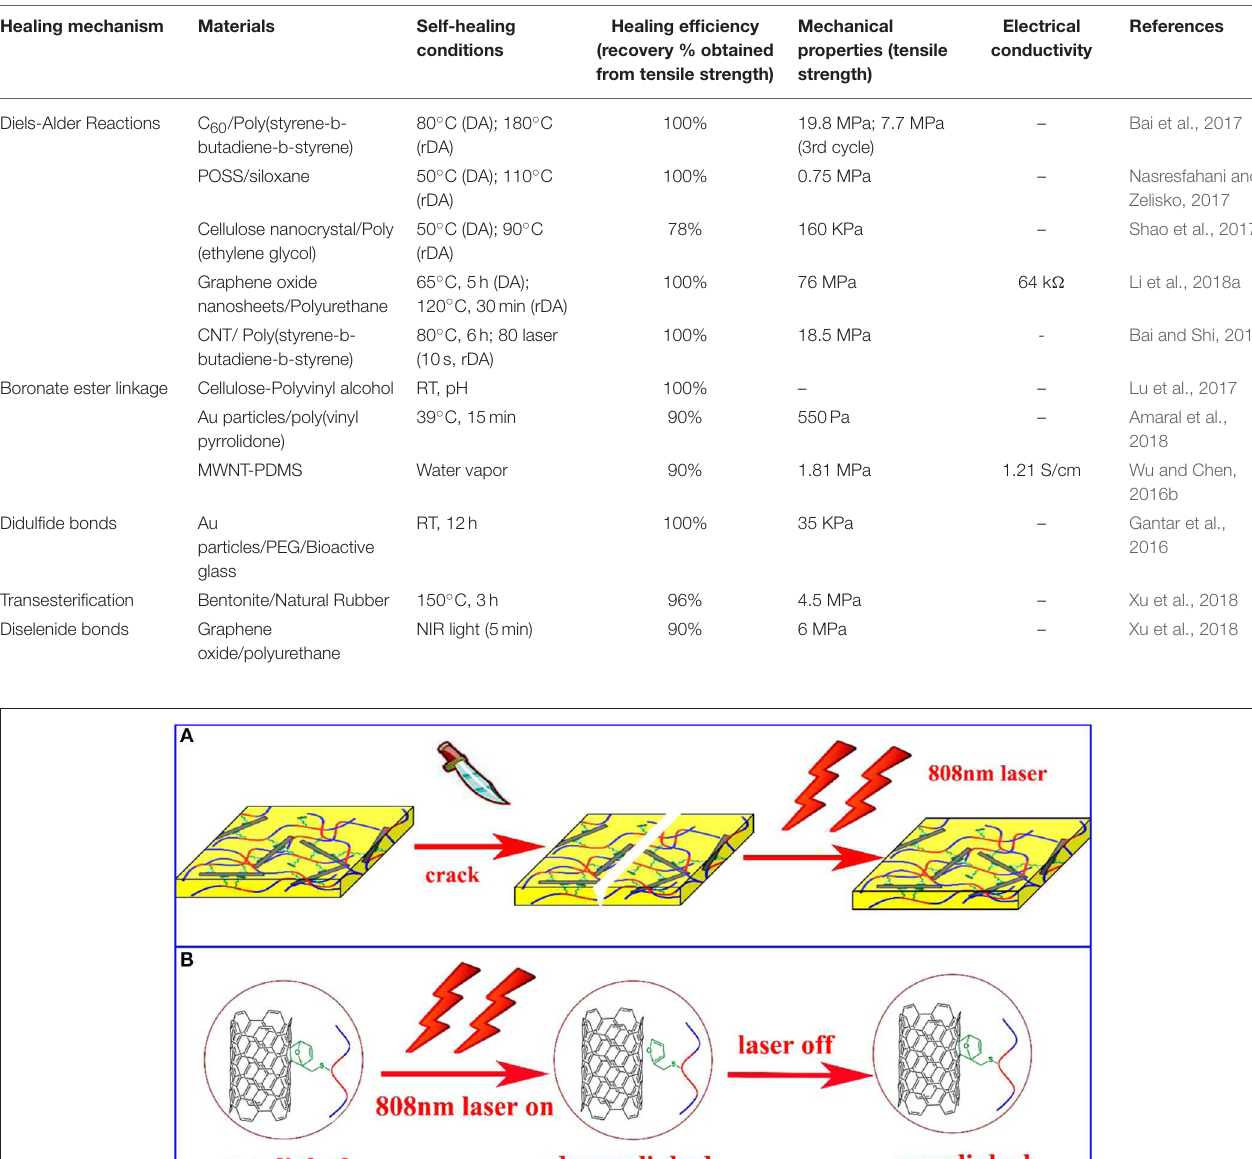
TABLE 4 | Chemical interaction based self-healing mechanism, healing efficiency, recovery, mechanical/electrical properties of soft nanocomposites.